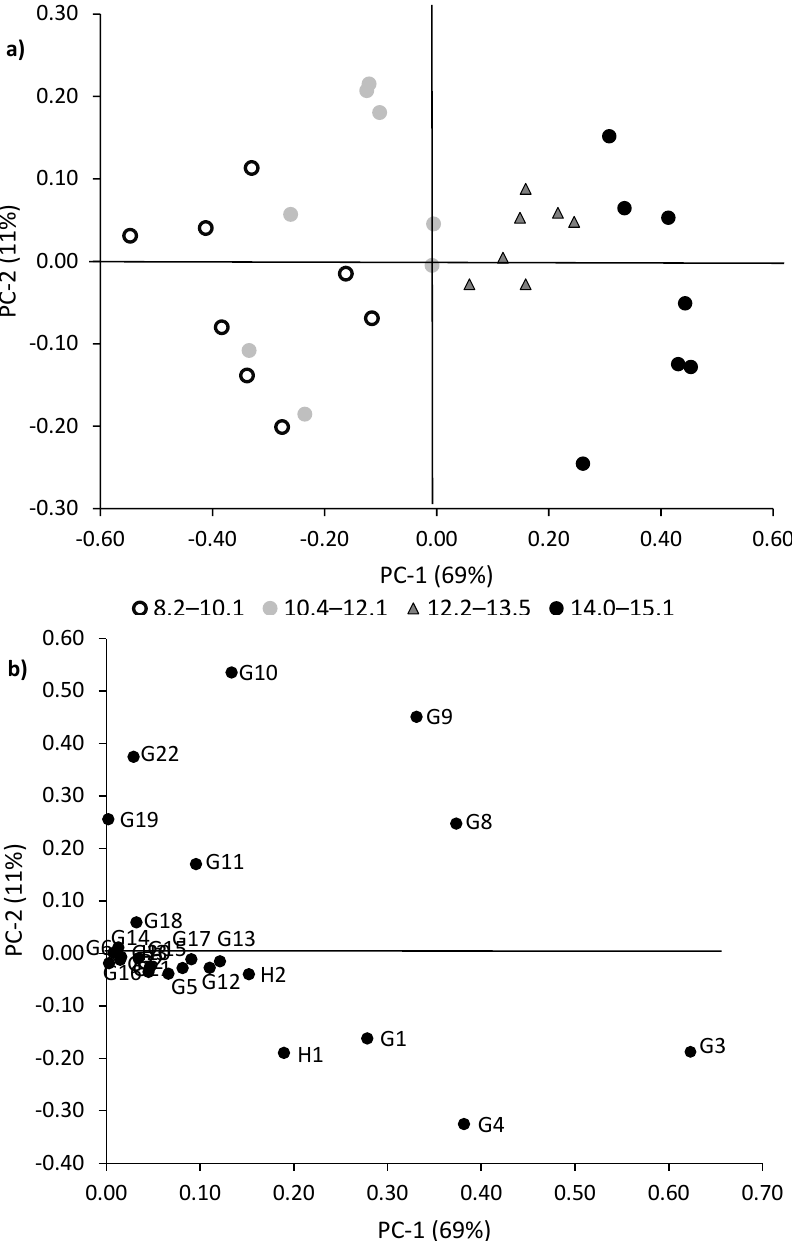
Figure 3. Principal scores plot of the PCA using all samples and G- and H-lignin products. ( a ) Scores plot PC 1 (69% explained variance) versus PC 2 (11% explained variance). Symbols represent 4 arbitrarily defined classes of Klason lignin content. ( b ) Loadings plot of the G and H-lignin variables (Table 1).